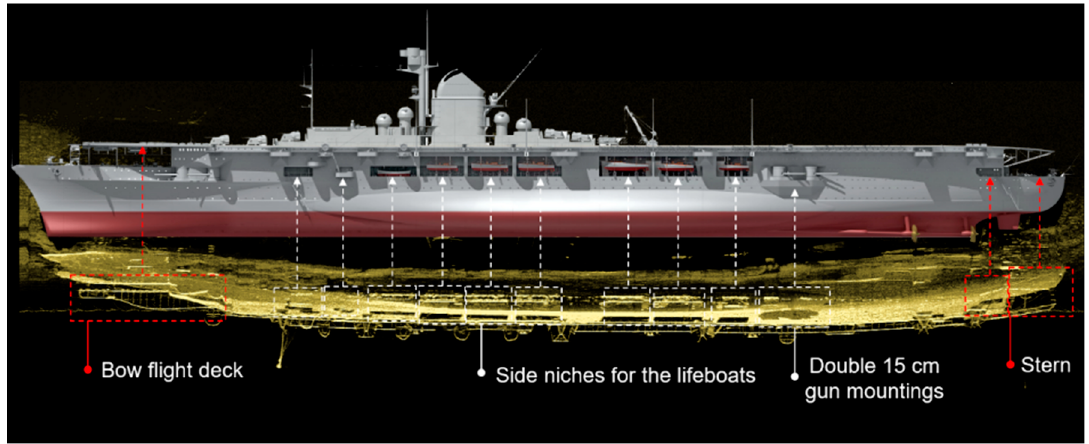
Figure 23. Location of side niches on the sonogram and the ship side silhouette.